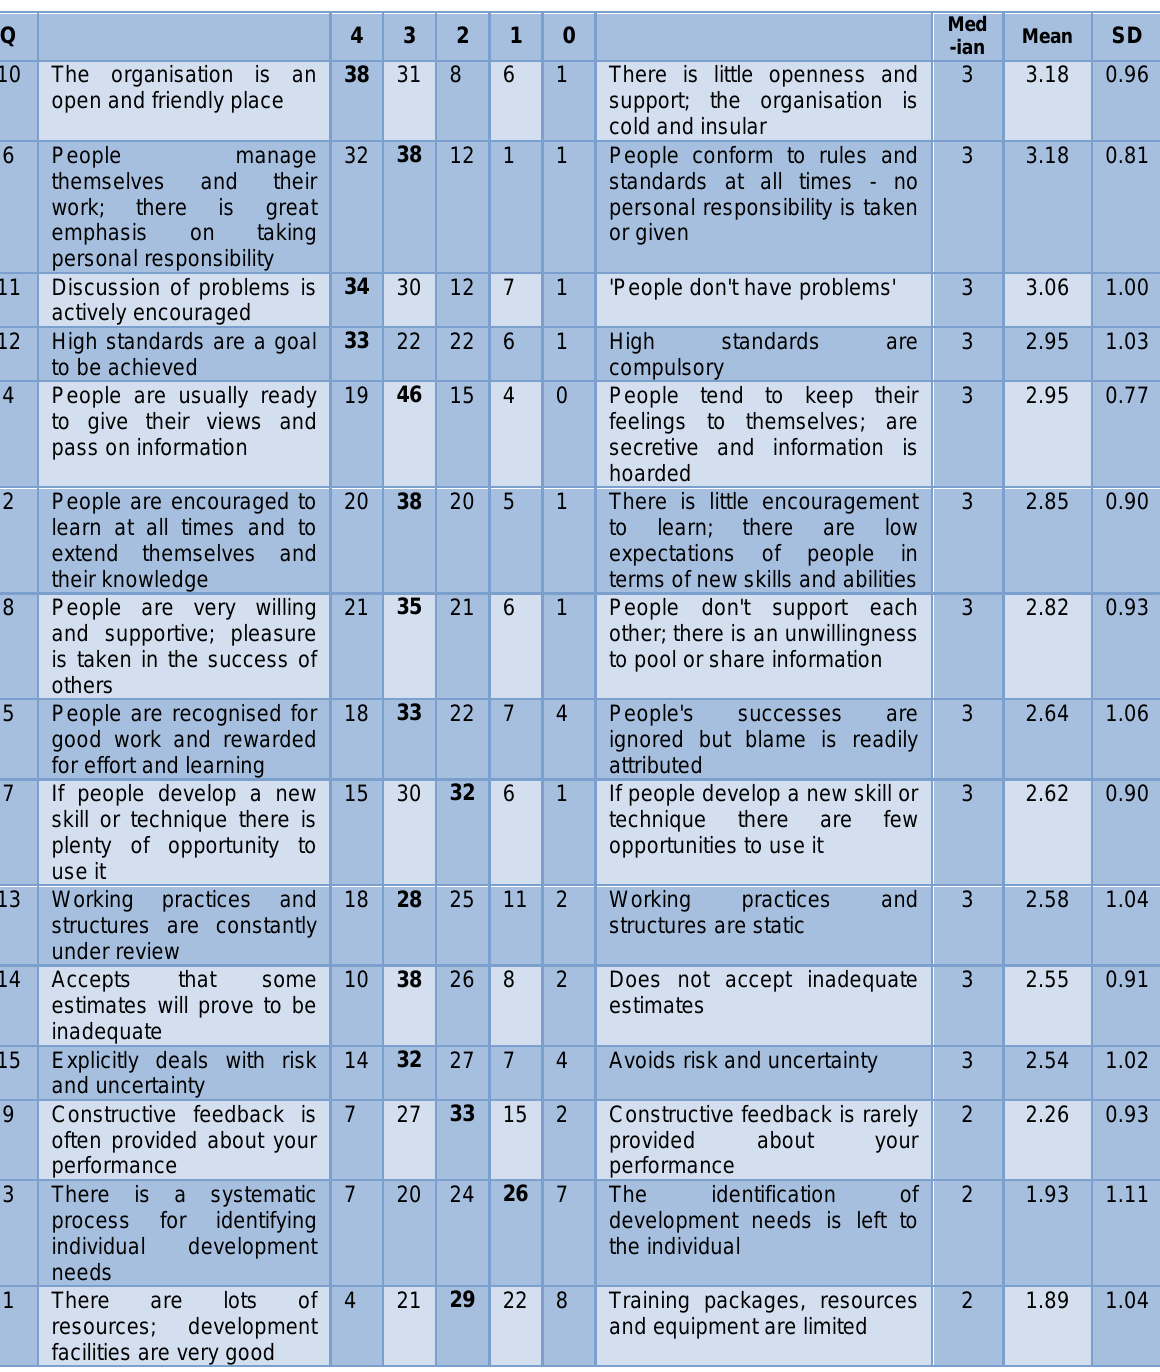
Table 1 Frequencies, means and standard deviations of individual items of the Learning Climate Questionnaire (LCQ) [n =